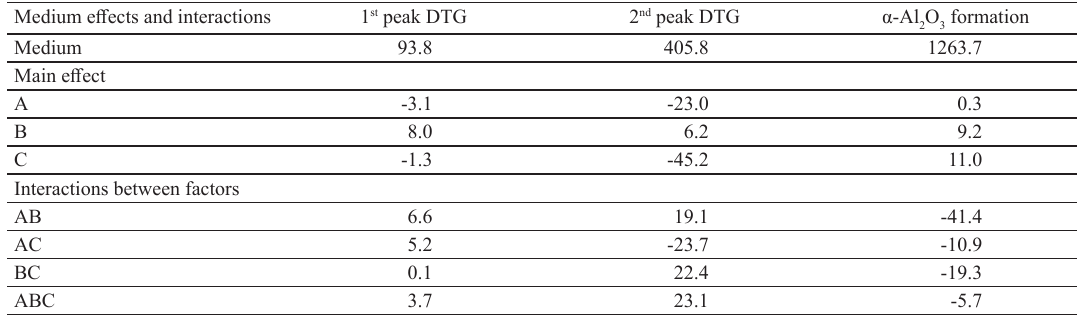
O formation. 2 3